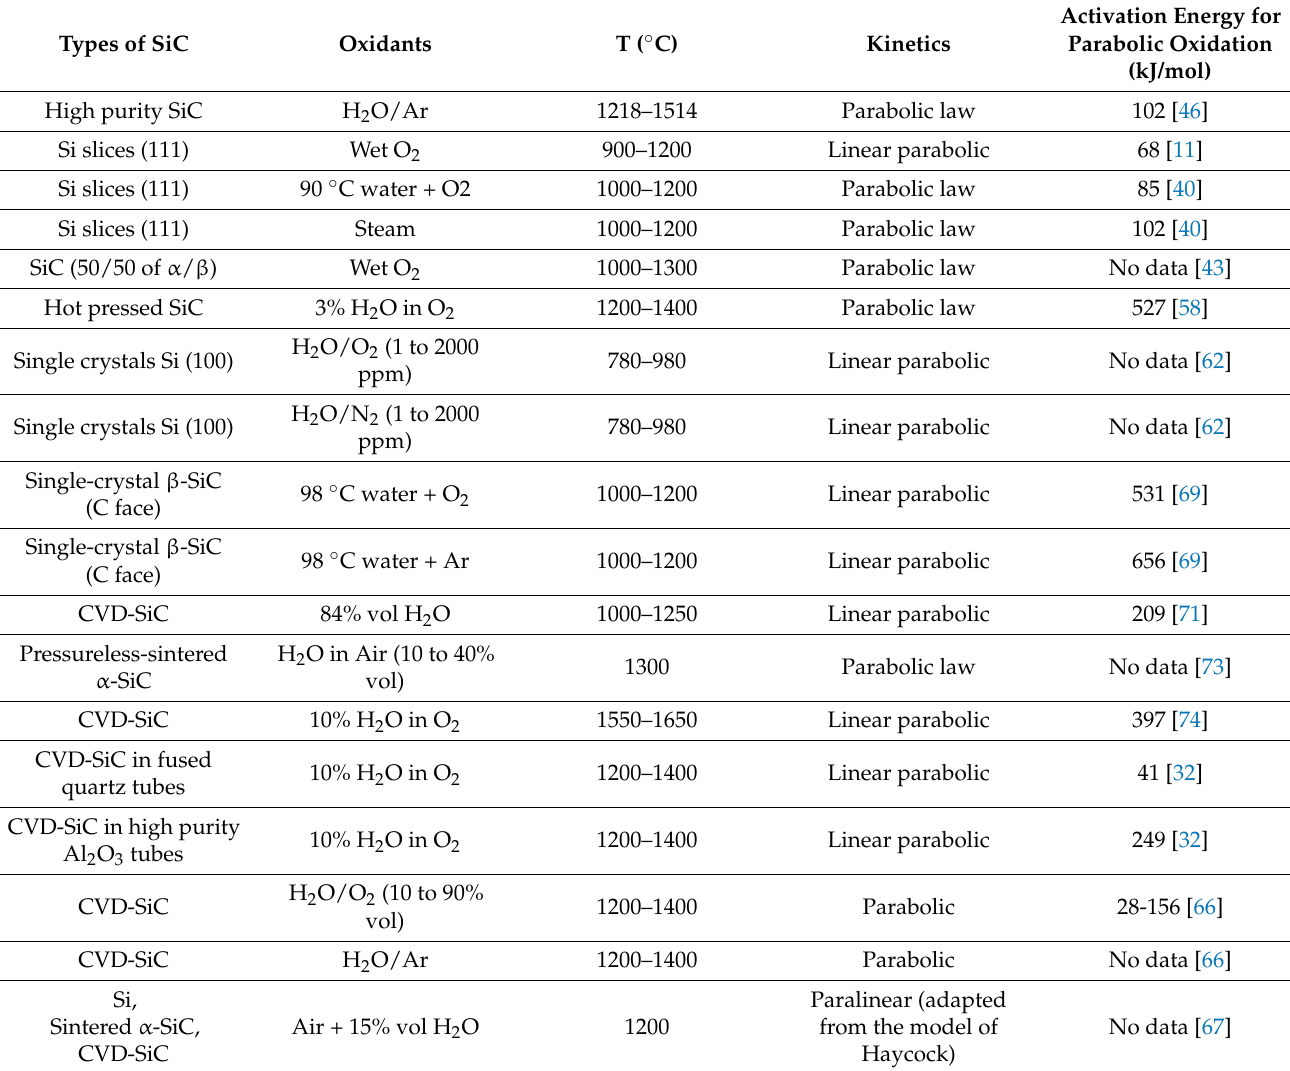
Table 4. Activation energies for parabolic oxidation of SiC in wet